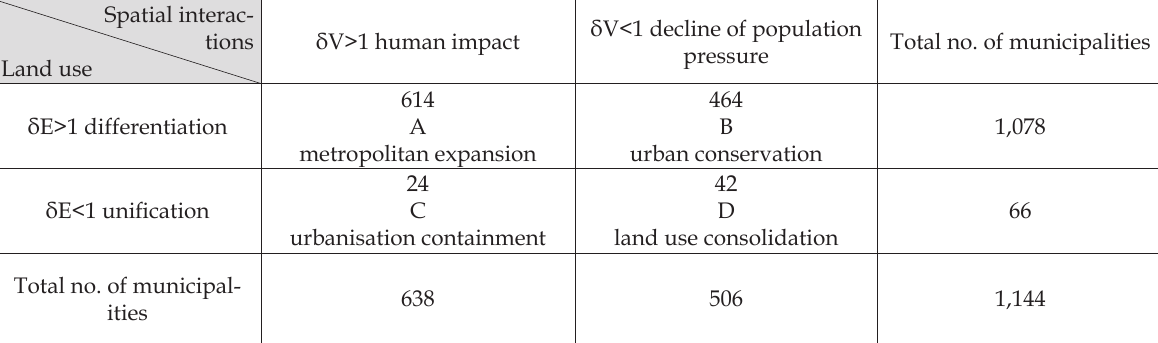
Table 2. Types of relations between quotients of population potential and quotients of entropy indices by num- ber of municipalities (2000/1990, see explanation in text)